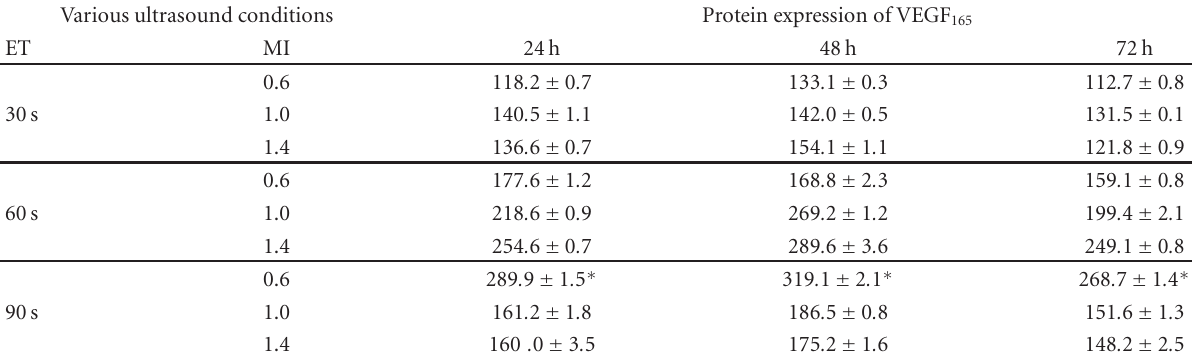
Table 2: Protein expression of VEGF 165 in mesenchymal stem cells supernatant after transfection under di ff erent ultrasound conditions ( n = 25,